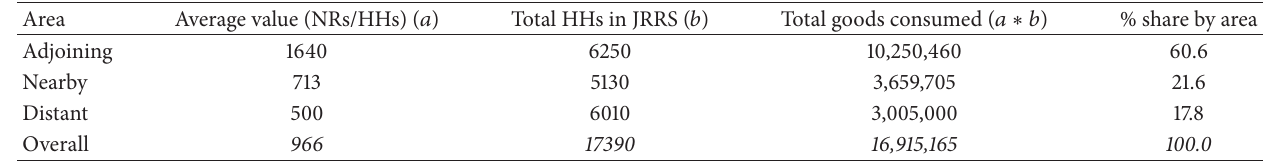
Table 5: Value of wetland goods consumed.